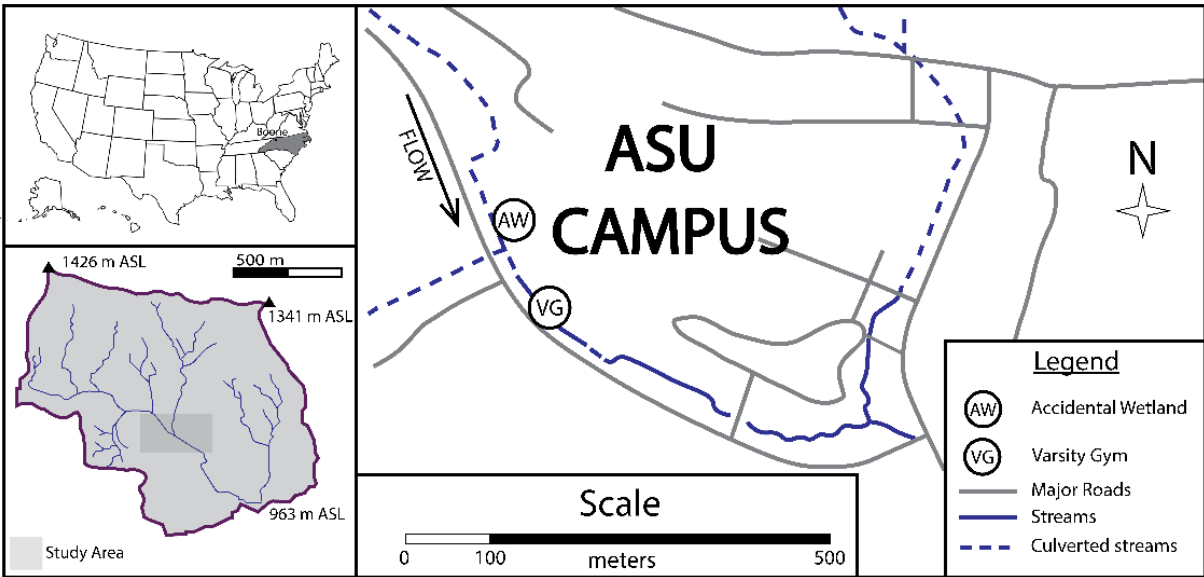
Figure 1. The Accidental Wetland (AW) site is located in Boone, North Carolina, USA (left top insert map) at 36°12′54.6′′ N 81°40′57.0′′ W. The solid blue line denotes the surface water of Boone Creek and the dashed blue line signifies culverted sections of Boone Creek. The circles indicate data collection sites, Accidental Wetland (AW) and Varsity Gym (VG). The bottom left insert map shows the Boone Creek watershed (heavy purple line) with the black triangles indicating peak elevations within the watershed. The arrow represents the direction of flow. ASL denotes above sea level. Adapted from ref. [20].